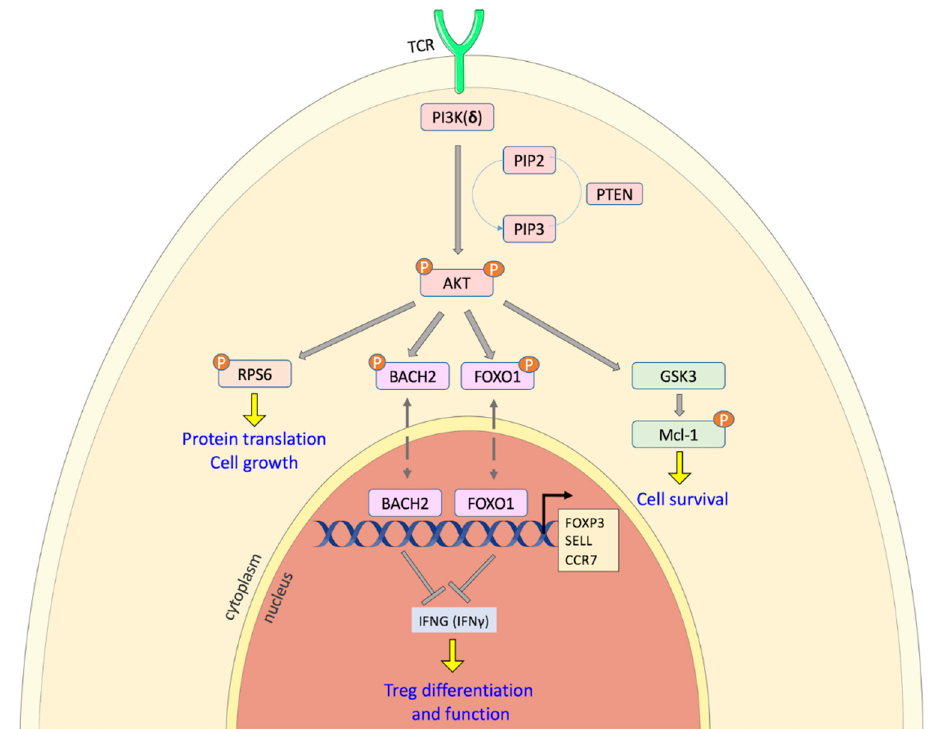
Figure 2. PI3K pathway in Tregs regulating anti-cancer immunity. Activated AKT pathway through PI3K δ signaling, the dominant isoform in Tregs, leads to the phosphorylation of the BACH2 and FOXO1 transcription factors and in this form they are sequestrated in the cytoplasm. BACH2 and FOXO1 are regulators of genes involved in Treg differentiation and function, such as FOXP3 , L-selectin ( SELL ), CCR7 and IFN γ . PI3K δ inhibition suppress Tregs functionality; they are not able to suppress any more anti-tumor responses. Proteins belonging to downstream TCR signaling are also regulated by PI3K δ , as pS6 phosphorylation and GSK-3 β activation, controlling proliferation, survival pathway and downstream degradation of the antiapoptotic protein